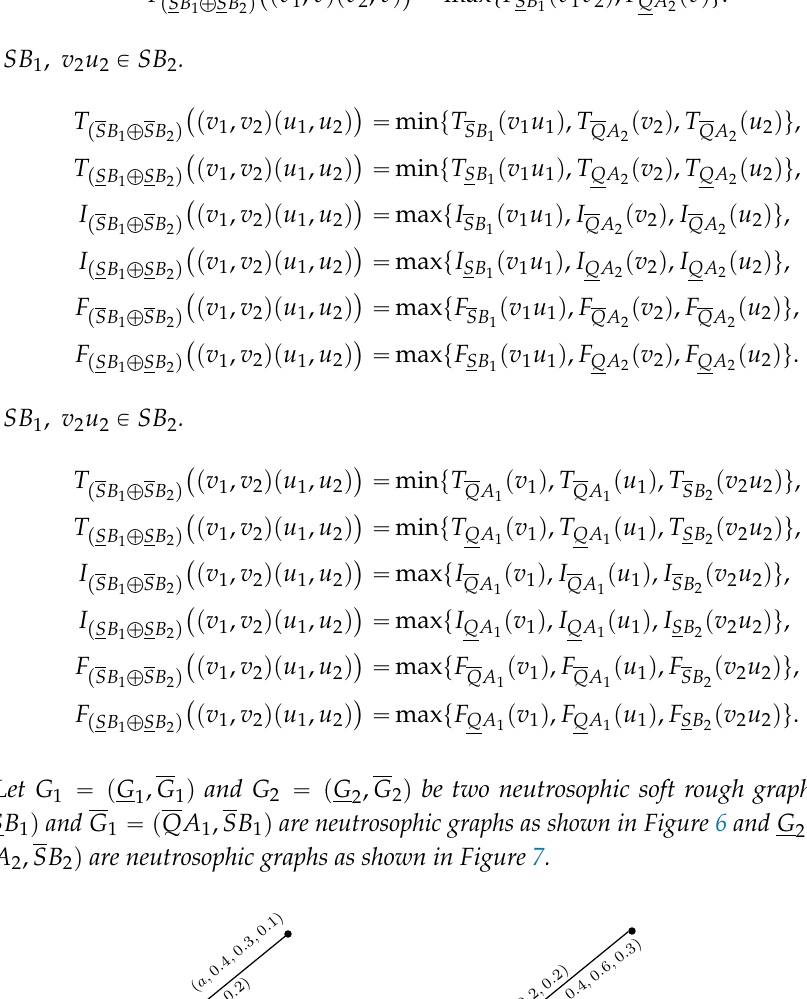
Figure 6: Neutrosophic soft rough graph G